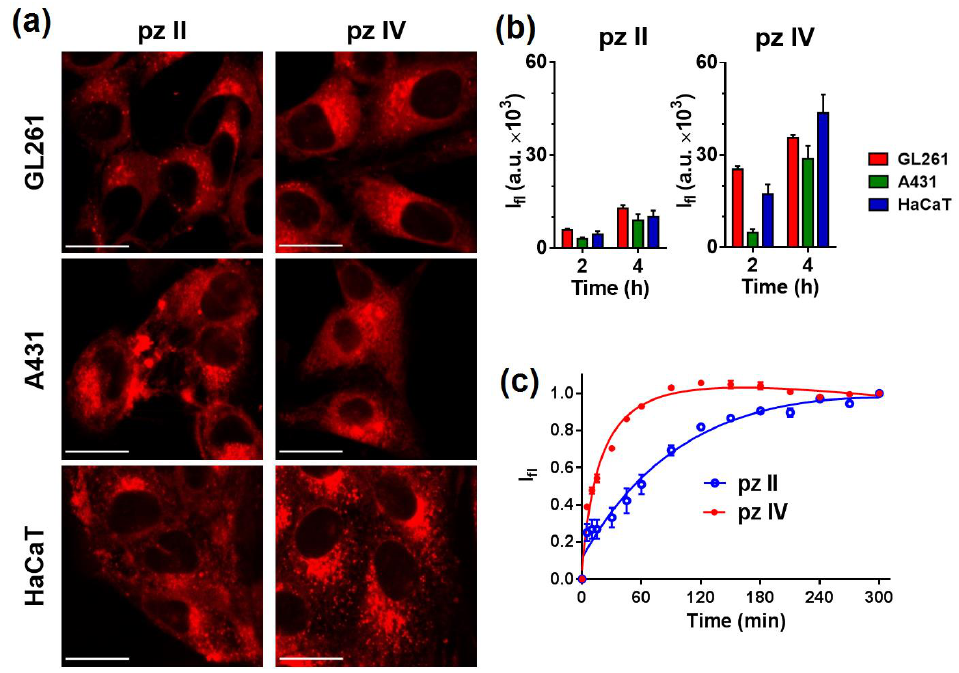
Figure 7. Analysis of the cellular uptake of pz II and pz IV . ( a ) Representative confocal images of murine glioma GL261, human epidermoid carcinoma A431, and human keratinocytes HaCaT cells after 240 min of incubation with the pz (10 µM). Scale bar, 20 µm . ( b ) Relative accumulation of the pz by cells of different lines after 2 and 4 h incubation, estimated from confocal microscopy experiment (n ≥ 10). ( c ) Dynamics of pz II and pz IV ’s accumulation in A431 cells. The pz was added t o the culture medium at a concentration of 5 µM, and a plate reader repeatedly measured the fluorescence in the well of the plate with the cell culture. The signal growth results from pz entering the intracellular environment with a higher local viscosity compared to outer culture medium.